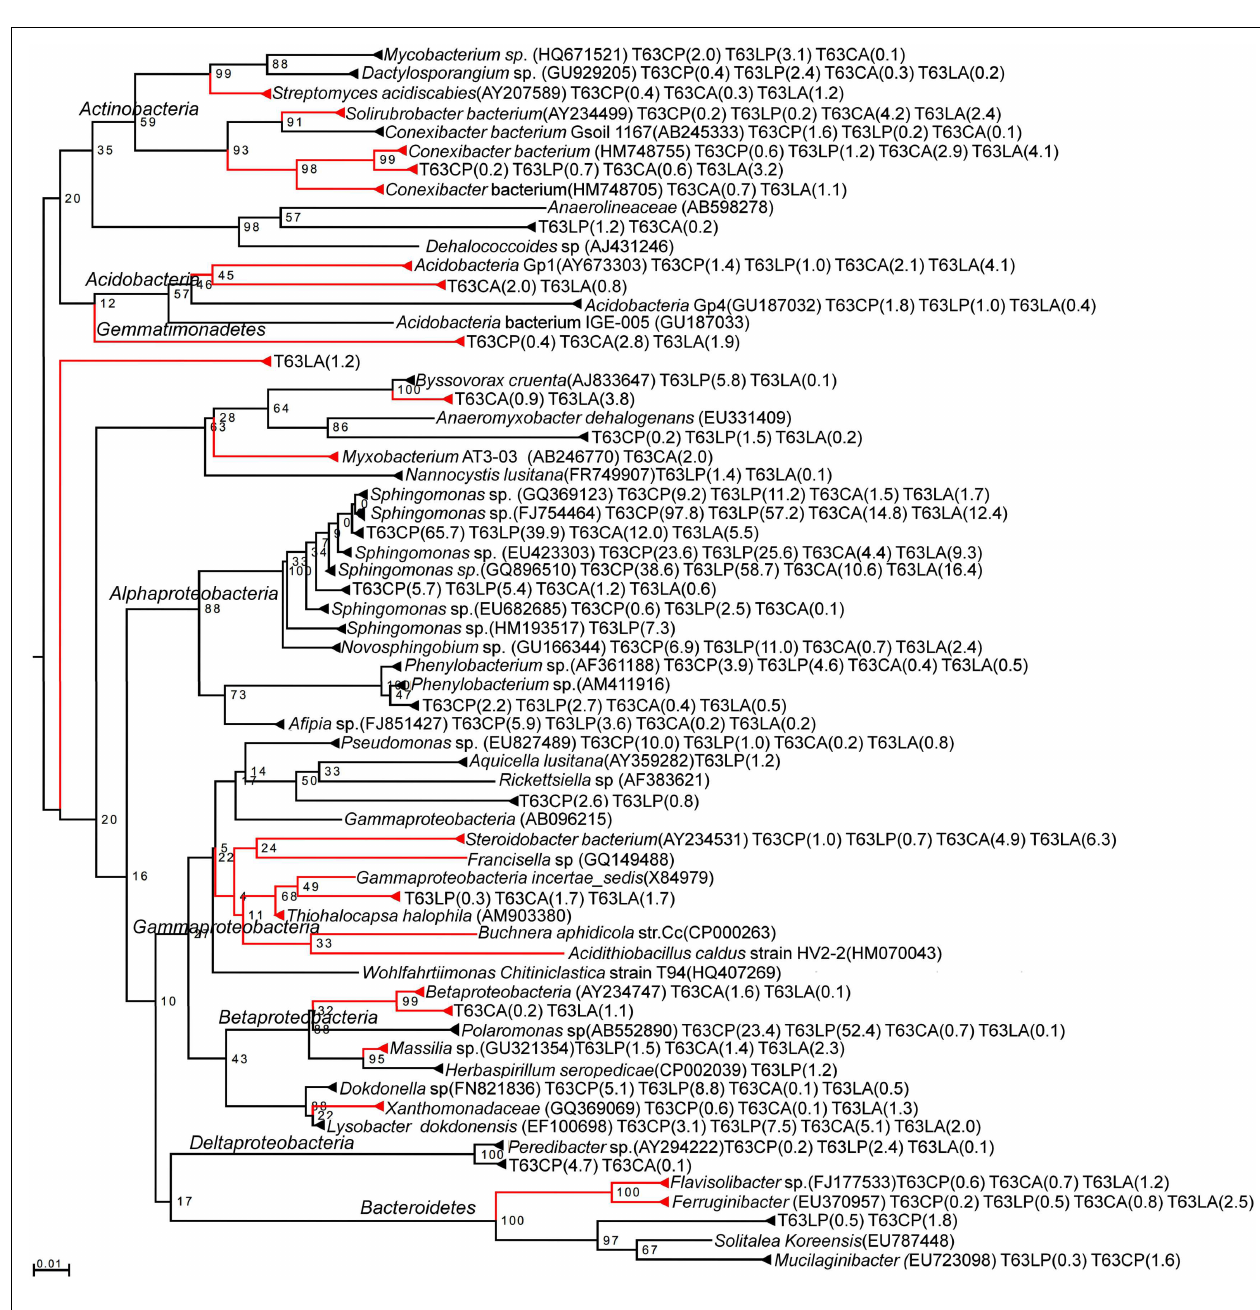
node = (bootstrap value/100) × 100. Number in brackets: relative abundance in %.T63, 63days after phenanthrene spiking; CA: Cambisol control, CP: phenanthrene-spiked Cambisol, LA: Luvisol control, LP: phenanthrene-spiked